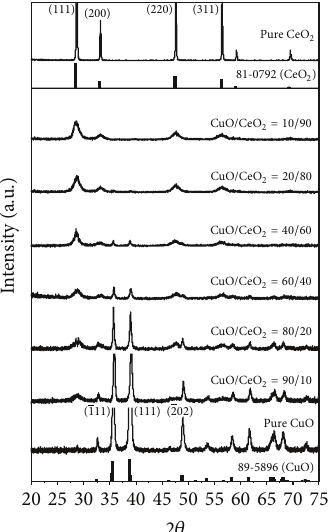
Figure 1: XRD patterns of CuO/CeO 2 catalysts for various CuO loadings.